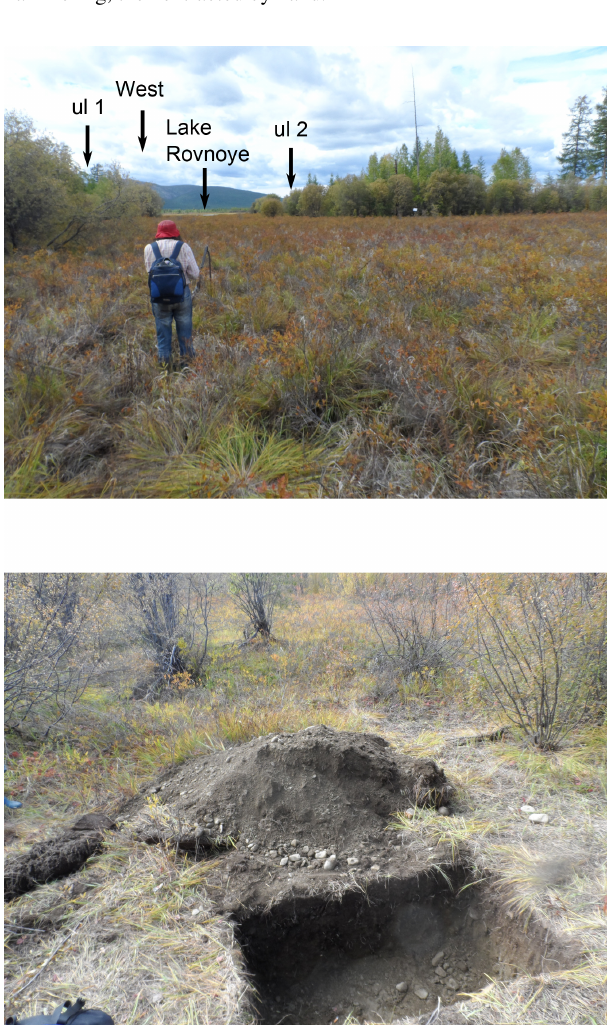
Figure A2. Sample sites of UL1 and UL2, both areas of slightly raised topography, apparently offset by the Ulakhan fault, and an example of excavated material from hole. Note the pebbles, some of which were from near the surface, but most of which came from sample